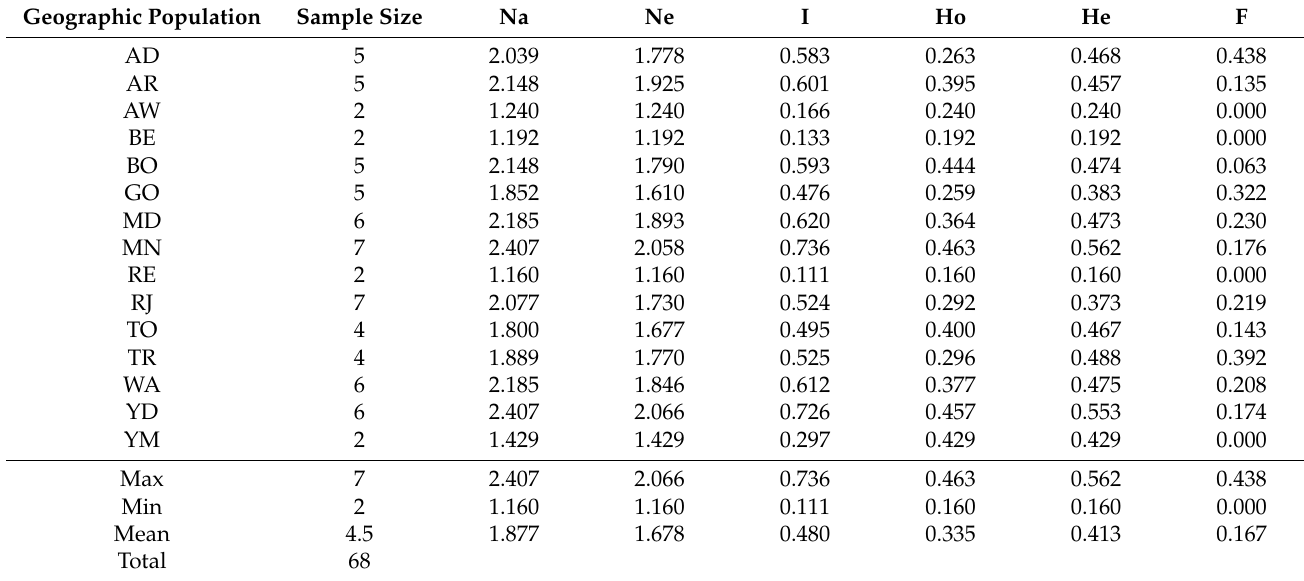
Table 3. Genetic diversity parameters of 15 maize landrace populations characterized with 27 SSR markers.